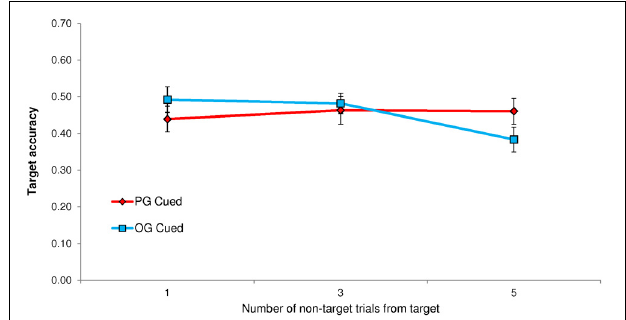
FIGURE 6 | Experiment 1 accuracy rates in the Sustained Attention to Response Task following personal-goal (PG) cues and other-goal (OG) cues, presented either 1, 3, or 5 non-target trials preceding the target and thought